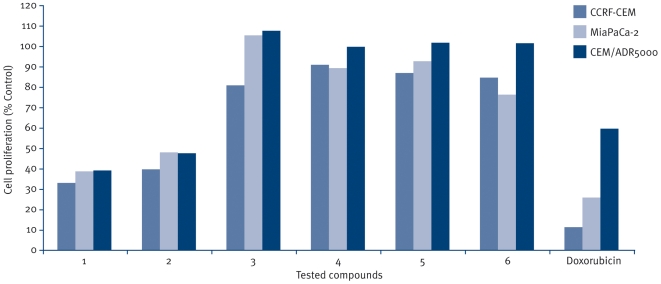
Growth percentage (%) of compounds and doxorubicin tested at 20 µg/ml on CCRF-CEM, CEM/ADR5000 and MiaPaCa-2 cell lines.
1: xanthone V1, 2: 2-acetylfuro-1,4-naphthoquinone; 3: physcion; 4: bisvismiaquinone; 5: vismiaquinone; 6: 1,8-dihydroxy-3-geranyloxy-6-methylanthraquinone. Data with different superscript letters are significantly different (P<0.05).